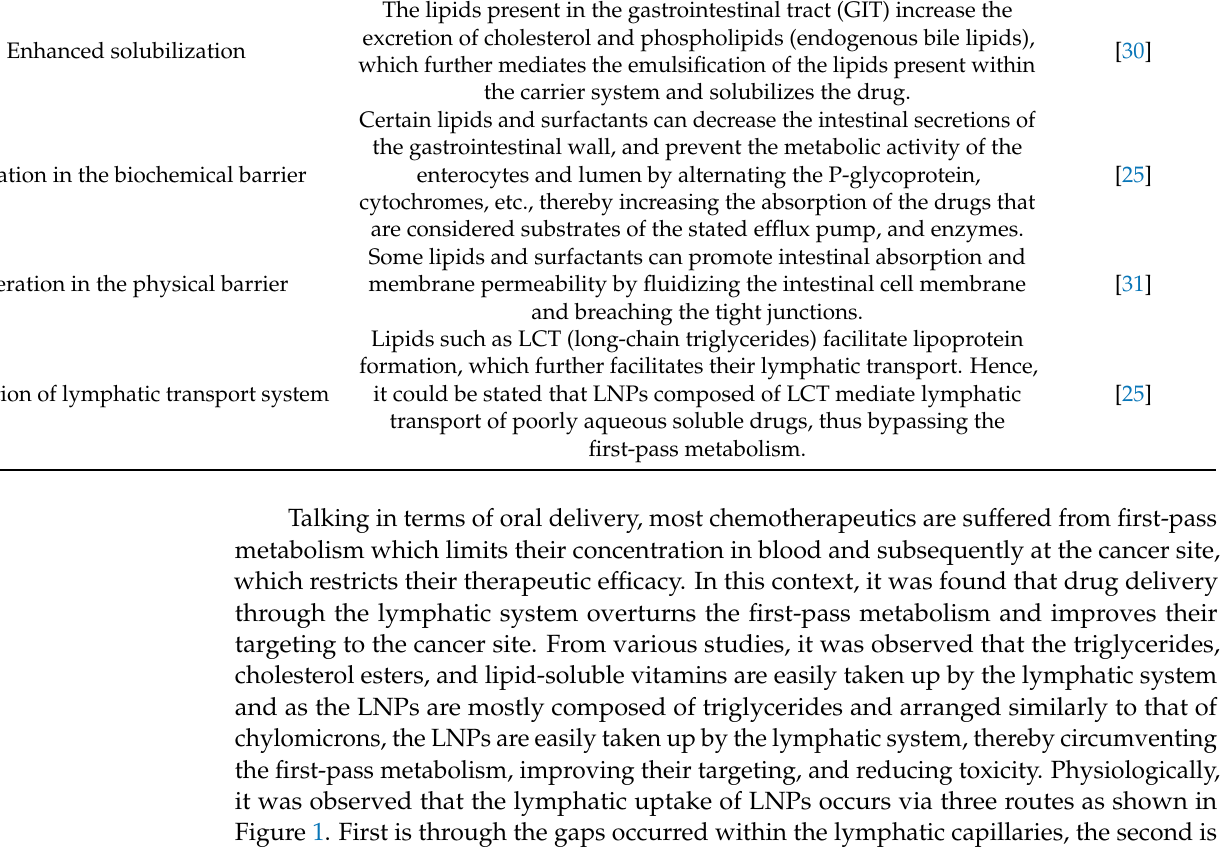
Table 1. Strategies employed for increasing the solubility of incorporated poorly water-soluble drugs by using LNPs.